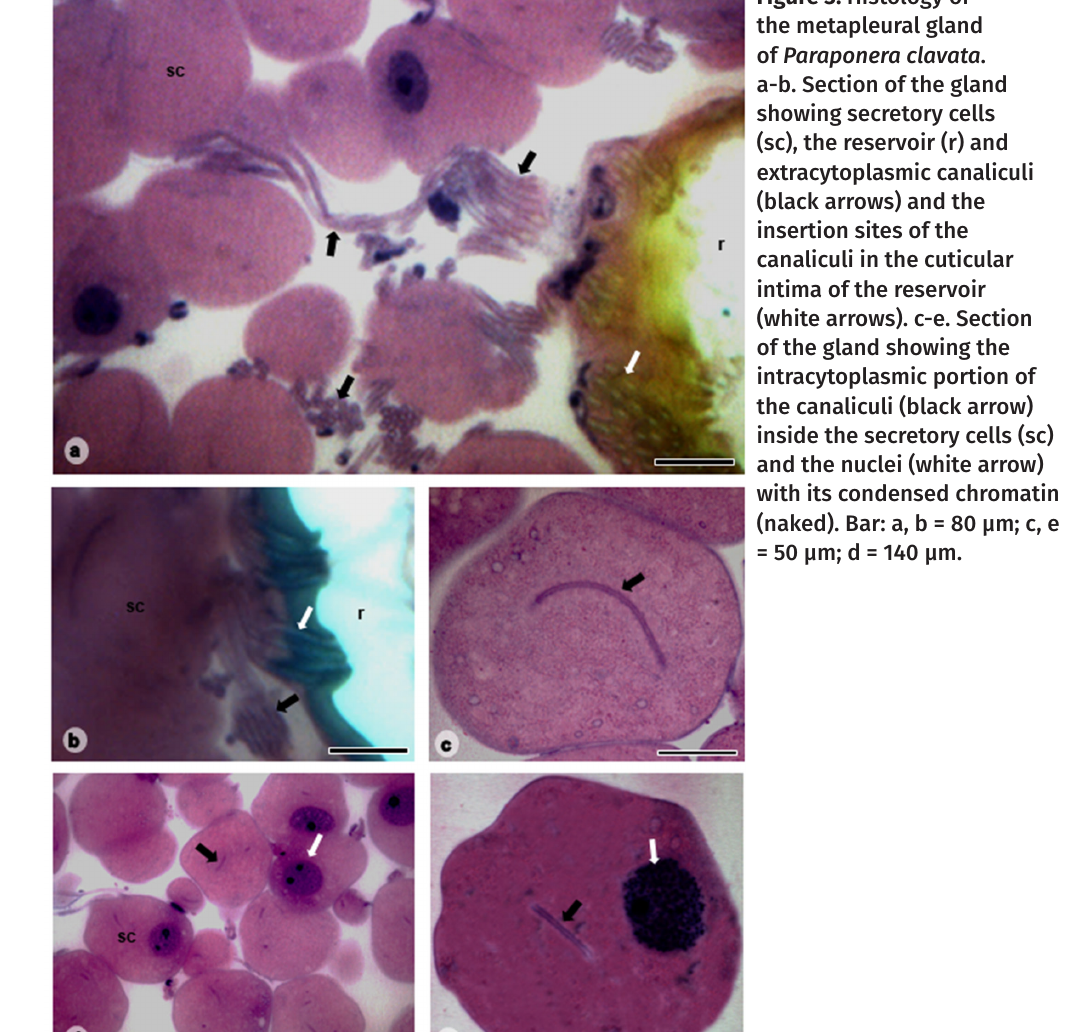
Figure 3. Histology of the metapleural gland of Paraponera clavata . a-b. Section of the gland showing secretory cells (sc), the reservoir (r) and extracytoplasmic canaliculi (black arrows) and the insertion sites of the canaliculi in the cuticular intima of the reservoir (white arrows). c-e. Section of the gland showing the intracytoplasmic portion of the canaliculi (black arrow) inside the secretory cells (sc) and the nuclei (white arrow) with its condensed chromatin (naked). Bar: a, b = 80 µm; c, e = 50 µm; d = 140